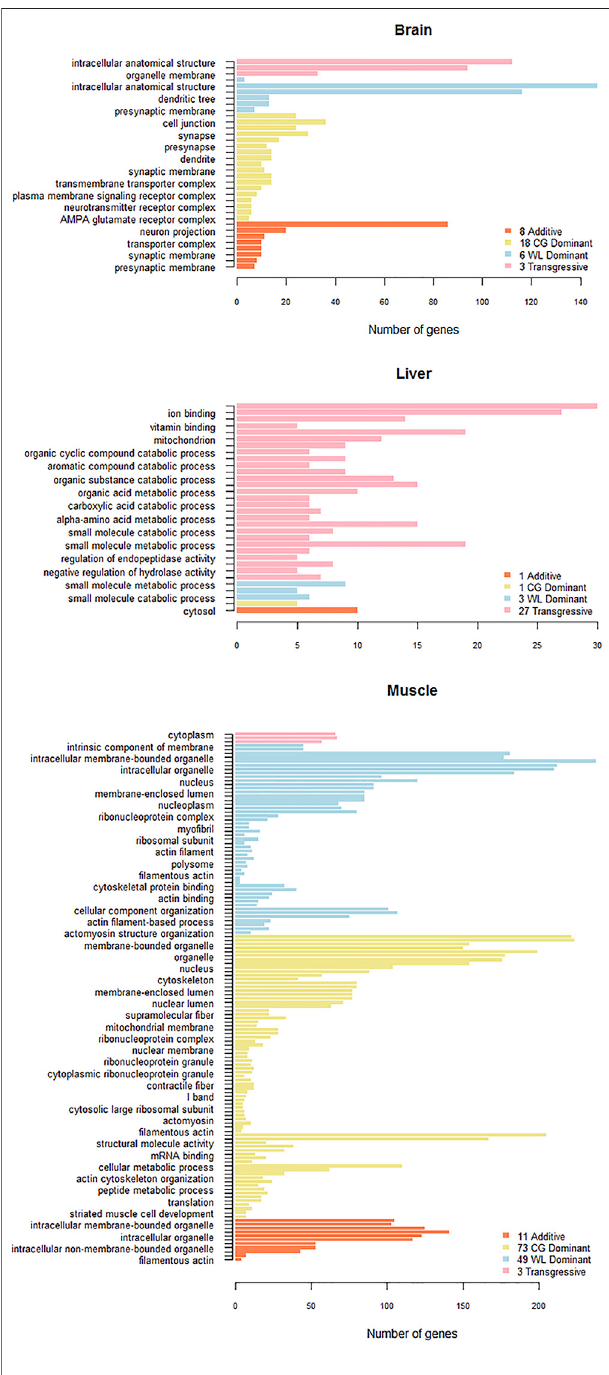
FIGURE 7 | Gene Ontology (GO) analysis of un-conserved pattern AS genes in three tissues. GO functional enrichment analysis is performed on additive, dominant and transgressive AS genes in brain, liver, and